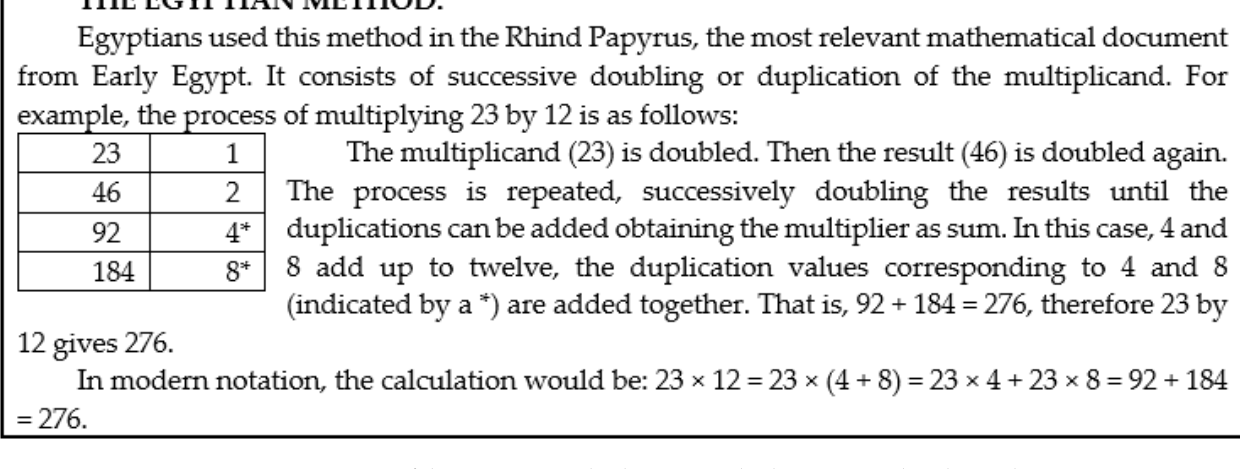
Figure 2. Description of the Russian peasants’ multiplication method as presented to the students. The same one ‐ hour ‐ long activity was carried out as part of a section devoted to the history of mathematics within the Disciplinary Instruction Complements for Mathematics and Computer Science module in the secondary and A ‐ level education teaching master’s degree (speciality in mathematics). The objective of so doing was to try and find out the poten ‐ tially different perceptions from primary teachers ‐ to ‐ be and their secondary/A ‐ level coun ‐ terparts, who already have more advanced knowledge on the matter since they, unlike the formers, need to have passed advanced mathematics courses to comply with the en ‐ trance requirements of their master’s degree.